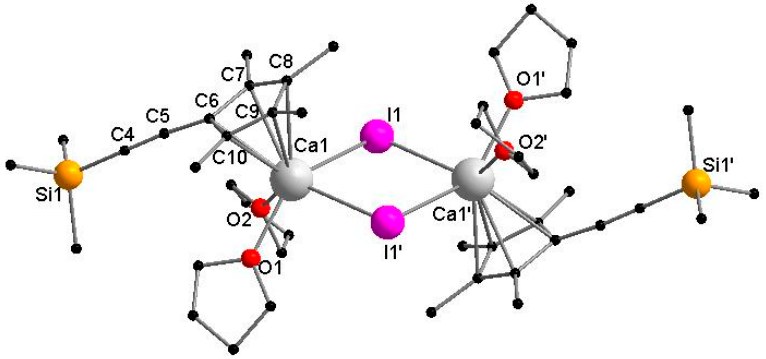
Figure 3. Molecular structure of 3 in the solid state. Hydrogen atoms are omitted for clarity. Selected bond lengths [Å] and angles [°]: Ca1–I1 3.0920(7), Ca1–I1’ 3.2039(7), Ca1–O1 2.369(3), Ca1–O2 2.410(3), Ca1–C6 2.634(3), Ca1–C7 2.686(4), Ca1–C8 2.734(5), Ca1–C9 2.733(5), Ca1–C10 2.687(4), C4–C5 1.199(5), I1–Ca1–I1’ 83.109(2), Ca1–I1–Ca1’ 96.891(2), O1–Ca1–O2 75.01(10), CpMe 4 (C ≡ CSiMe 3 )-Centroid–Ca1–I1 109.320(1), CpMe 4 (C ≡ CSiMe 3 )-Centroid–Ca1–I1 (cid:48)